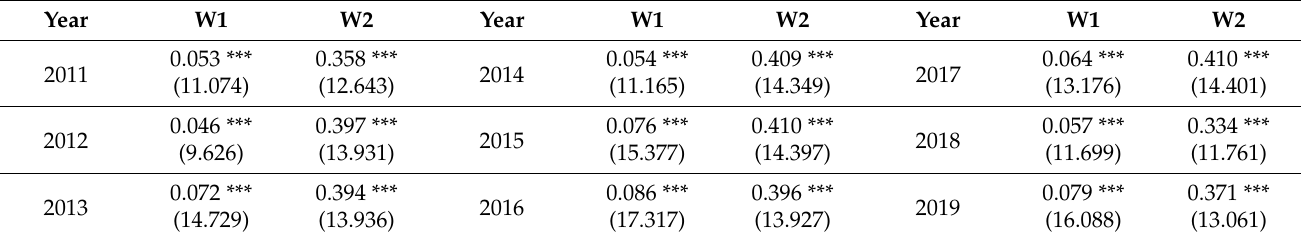
Table 5. Global spatial correlations of